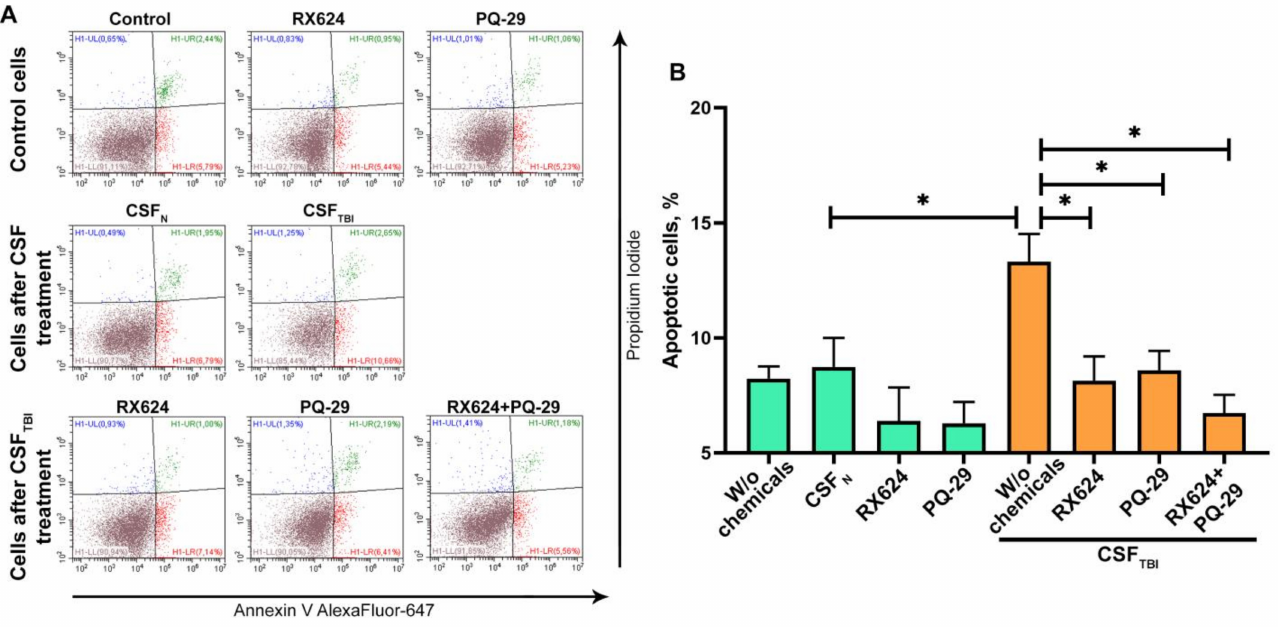
Figure 3. Analysis of the proportion of apoptotic cells in the population after incubation in the presence of CSF of traumatized rats and therapeutic compounds. CSF N is the cerebrospinal fluid of naive animals. CSF TBI is the cerebrospinal fluid of traumatized animals. ( A ) Distribution of the cell population according to flow cytometry data after cell staining with the apoptosis marker annexin V. ( B ) The results of analysis using the flow cytometry method are presented as a bar graph. The mean values ± standard deviations of the results of three independent experiments are shown; differences are significant at * p < 0.05 (Mann–Whitney